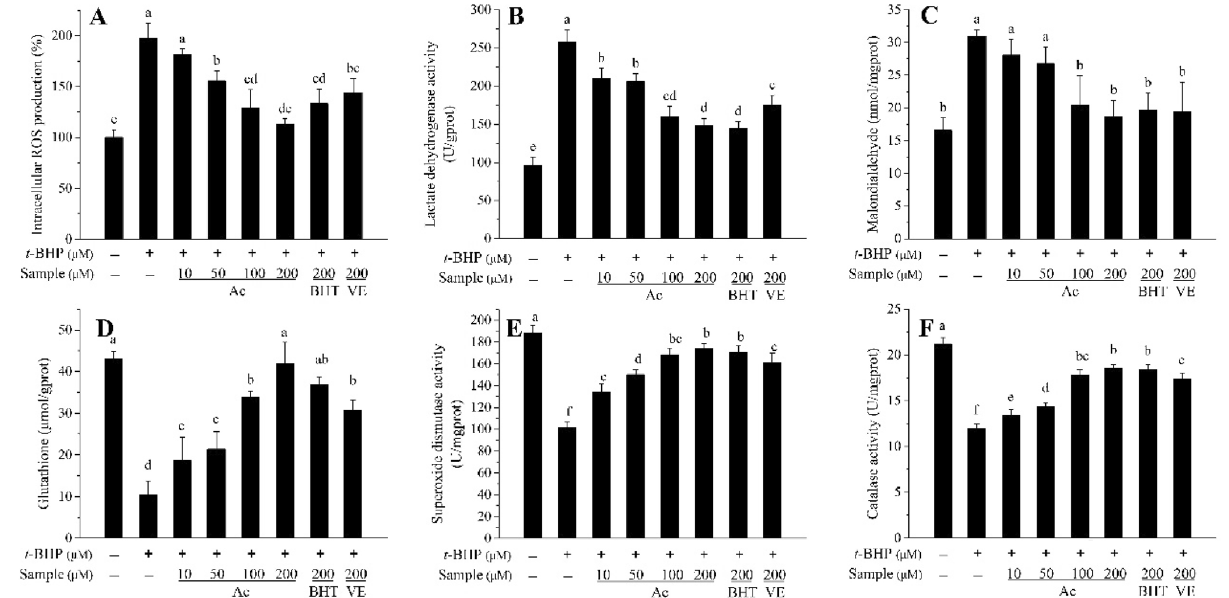
Figure 5. Effects of Ac, BHT, and VE on the indicators of HepG2 cellular antioxidant defense. ( A ) Effects of Ac, BHT, and VE on intracellular ROS. ( B ) Effects of Ac, BHT, and VE on extracellular lactate dehydrogenase activity. ( C ) Effects of Ac, BHT, and VE on extracellular malondialdehyde level. ( D ) Effects of Ac, BHT, and VE on GSH level. ( E ) Effects of Ac, BHT, and VE on SOD activity. ( F ) Effects of Ac, BHT, and VE on CAT activity. HepG2 cells were treated with 30 μg/mL samples for 6 h before being exposed to TBHP (700 μmol/L) for 3 h. ROS level, LDH activity, MDA level, GSH level, SOD activity, and CAT activity in HepG2 cells were detected through the kit. Different letters above bars indicate significant difference (by ANOVA, p < 0.05). Results are expressed as mean ± SD (n ≥ 3). Ac, acteoside; BHT, butylated hydroxytoluene; VE, vitamin E; + , treated; −,